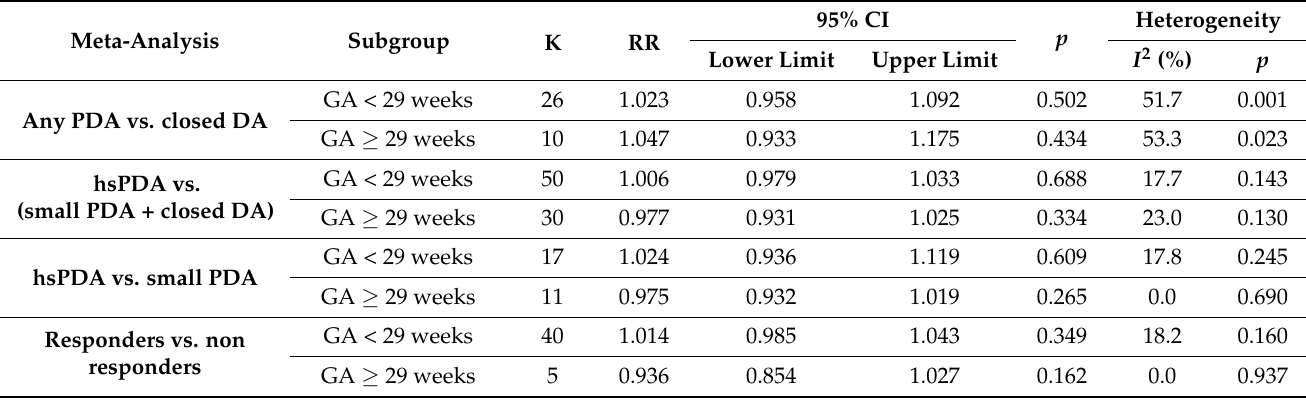
Table 2. Subgroup analysis based on inclusion criteria for gestational age.